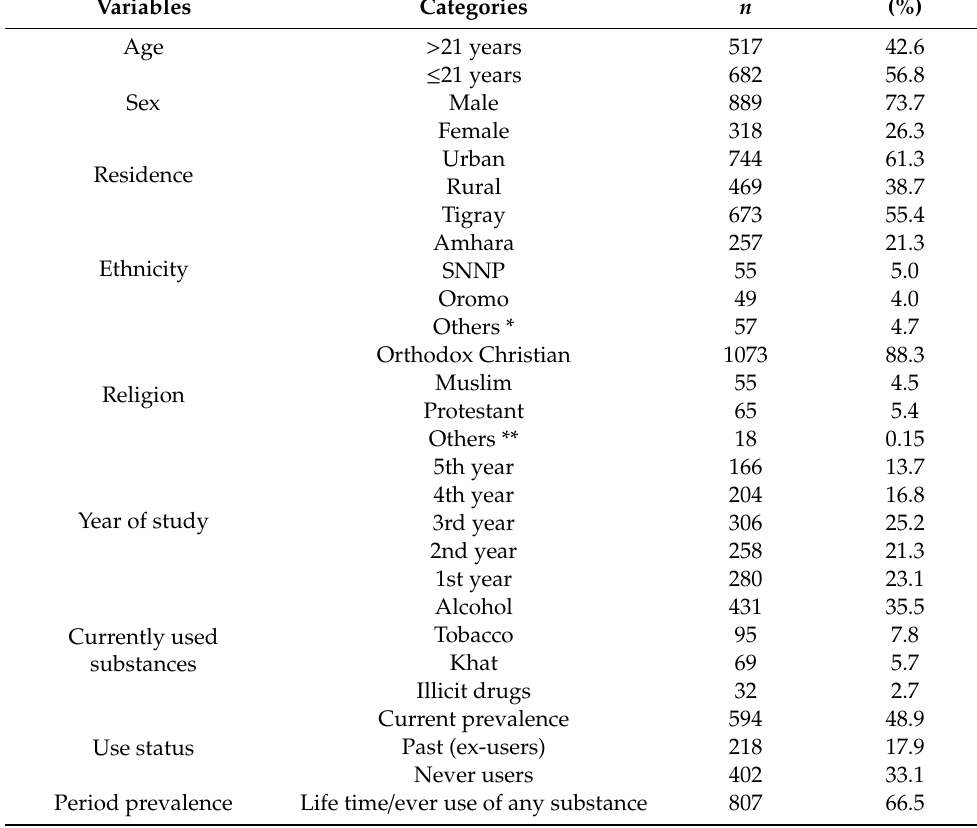
Table 1. Socio-demographic characteristics of Mekelle University undergraduate students in Ethiopia in 2017 ( n =